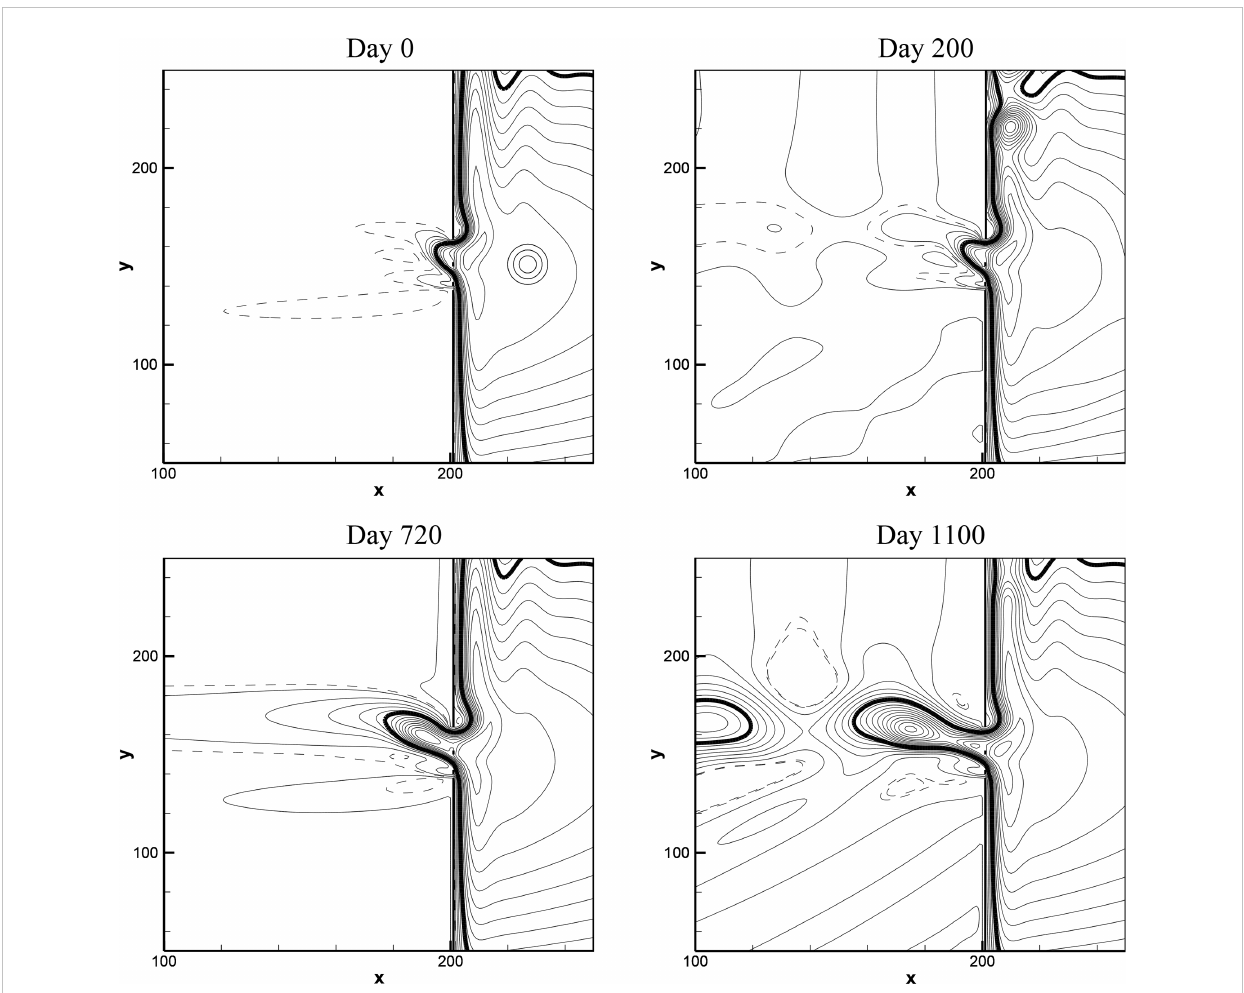
FIGURE 9 Time evolution of the WBC critical from the leaping to eddy-shedding regime at Re = 44 impinged by a cyclonic eddy in the vicinity of the gap with two islands. The cyclonic eddy with a radius of 80 km is inserted 300 km east of the gap into background fl ow and propagates toward the gap. The critical strength of the eddy is y c = 28,000 m 2 s − 1 to induce the critical WBC transition from leap to penetration. WBC, western boundary